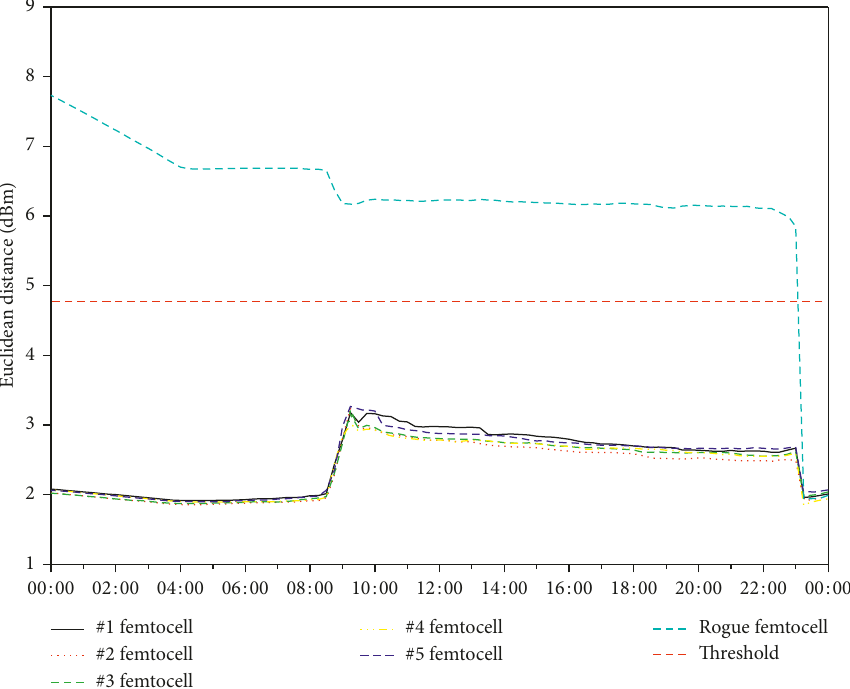
Figure 6: Average Euclidean distances of stationary rogue femtocells.